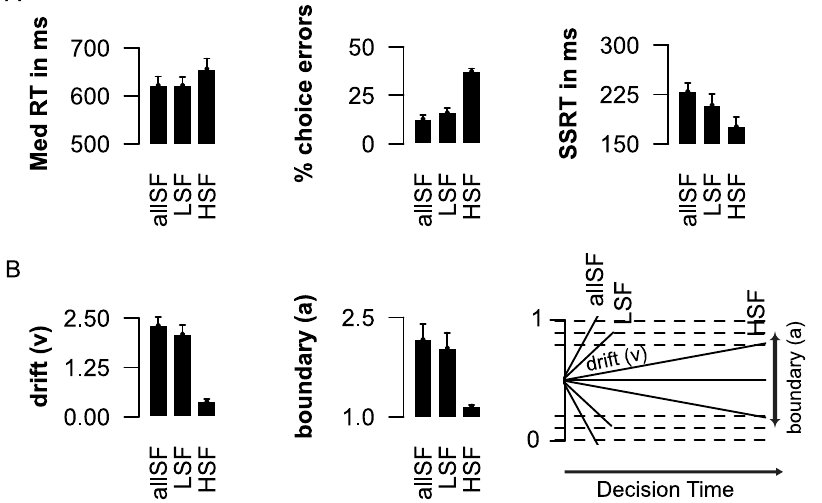
Figure 4. Experiment 1: Effects of spatial frequency information during the visual stop task. A) Both Go RT (left panel) and % choice errors (middle panel) increased when spatial frequency information was degraded. There right panel shows how the efficiency to withdraw a response (SSRT) improves, when categorization is more difficult. B) HDDM individual subject parameter estimates. When spatial frequency information was removed, the rate of information accumulation, ‘‘drift rate’’ ( v ) decreased (left panel), whereas the decision ‘‘boundary’’ ( a ) to categorize the face stimuli on time was lowered (middle panel). The right panel illustrates how lower drift rates, and decision boundaries together can result in prolonged RT and more